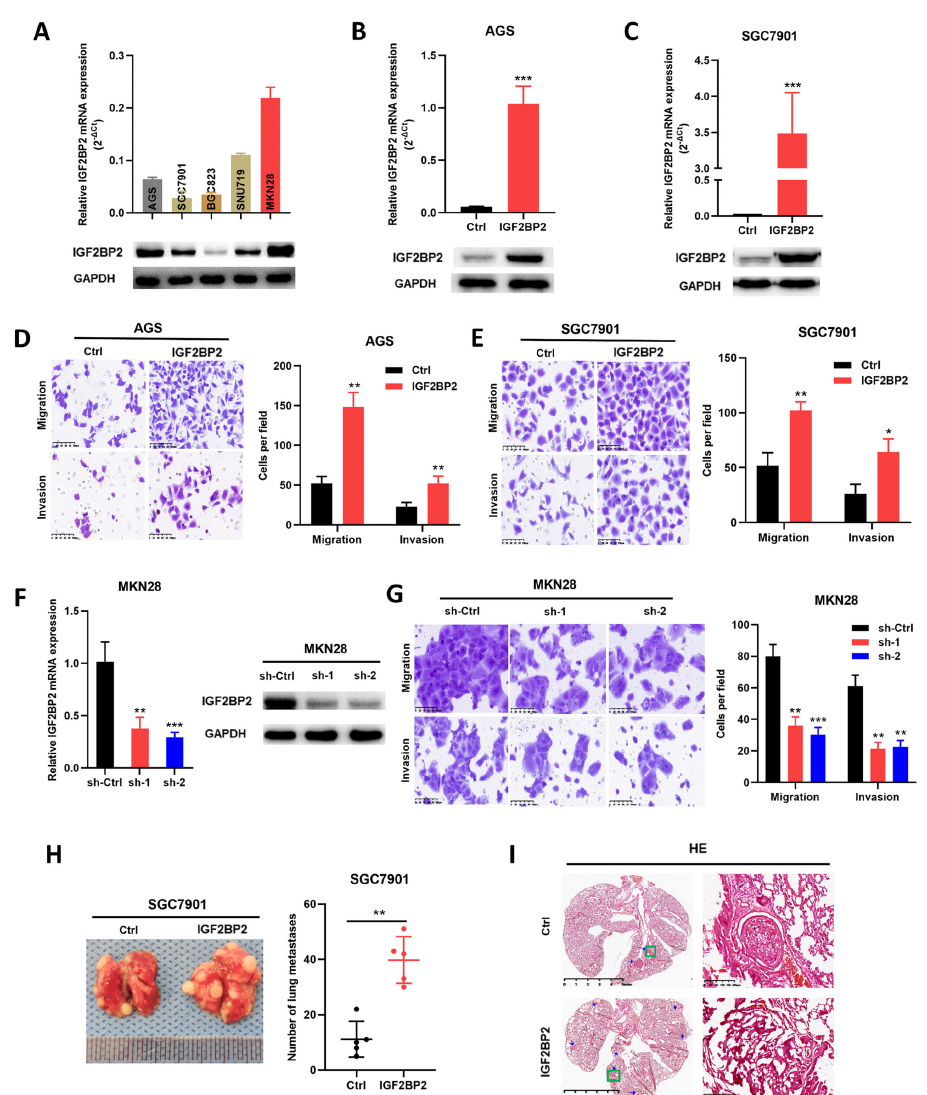
Figure 2. IGF2BP2 promotes in vivo and in vitro metastasis of GC cells. ( A ) The mRNA and protein levels of IGF2BP2 in GC cell lines. ( B , C ) Western blotting and RT-PCR were performed to confirm the stable IGF2BP2-overexpressing AGS and SGC7901 cells were constructed successfully. ( D , E ) The migration and invasion capability of AGS and SGC7901 cells were significantly increased by the upregulation of IGF2BP2. ( F ) Western blotting and RT-PCR were performed to confirm the sta- ble IGF2BP2 knockdown MKN28 cells were constructed successfully. ( G ) Migration and invasion capabilities of MKN28 were significantly inhibited by the knocking down of IGF2BP2. ( H ) Represen- tative images and quantification of metastatic lung tumors after IGF2BP2-overexpression or control SGC7901 cells were injected. ( I ) Representative images depicting lung-tumor l metastasis through HE staining. * p < 0.05, ** p < 0.01, *** p < 0.001. Molecular weights for proteins are shown in